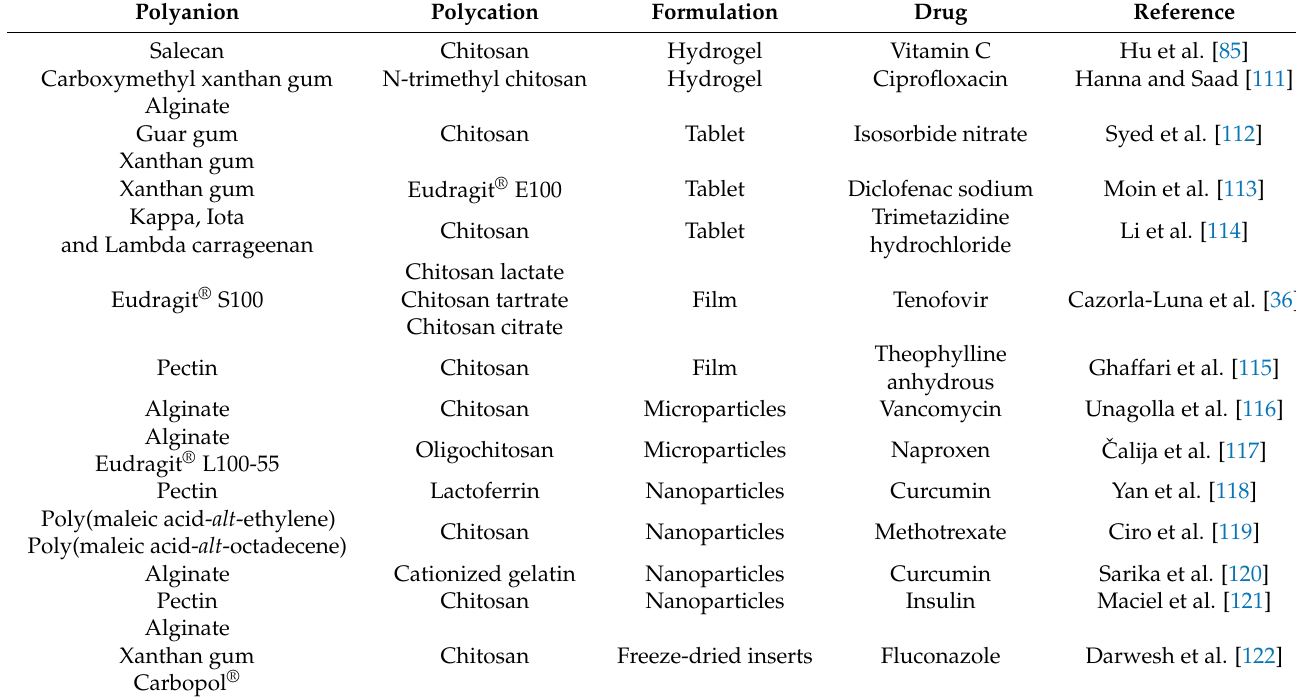
Table 1. Examples of drug delivery systems manufactured with biopolymer-based polyelectrolyte